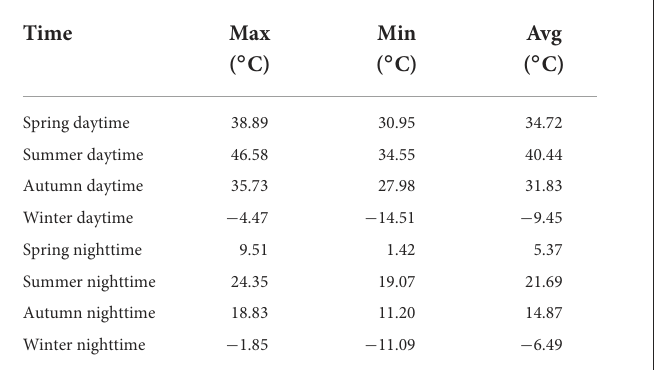
TABLE 3 Statistical results of diurnal surface temperature in different seasons.